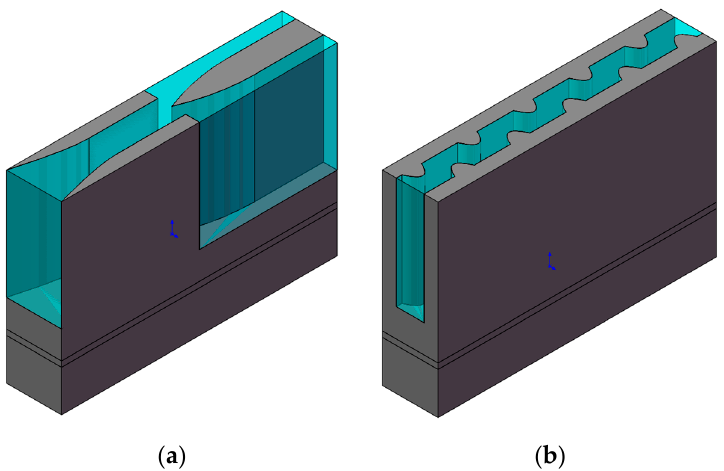
Figure 13. The unit models of the micro-channel heat sinks: ( a ) MC-SF; ( b ) MC-SR.